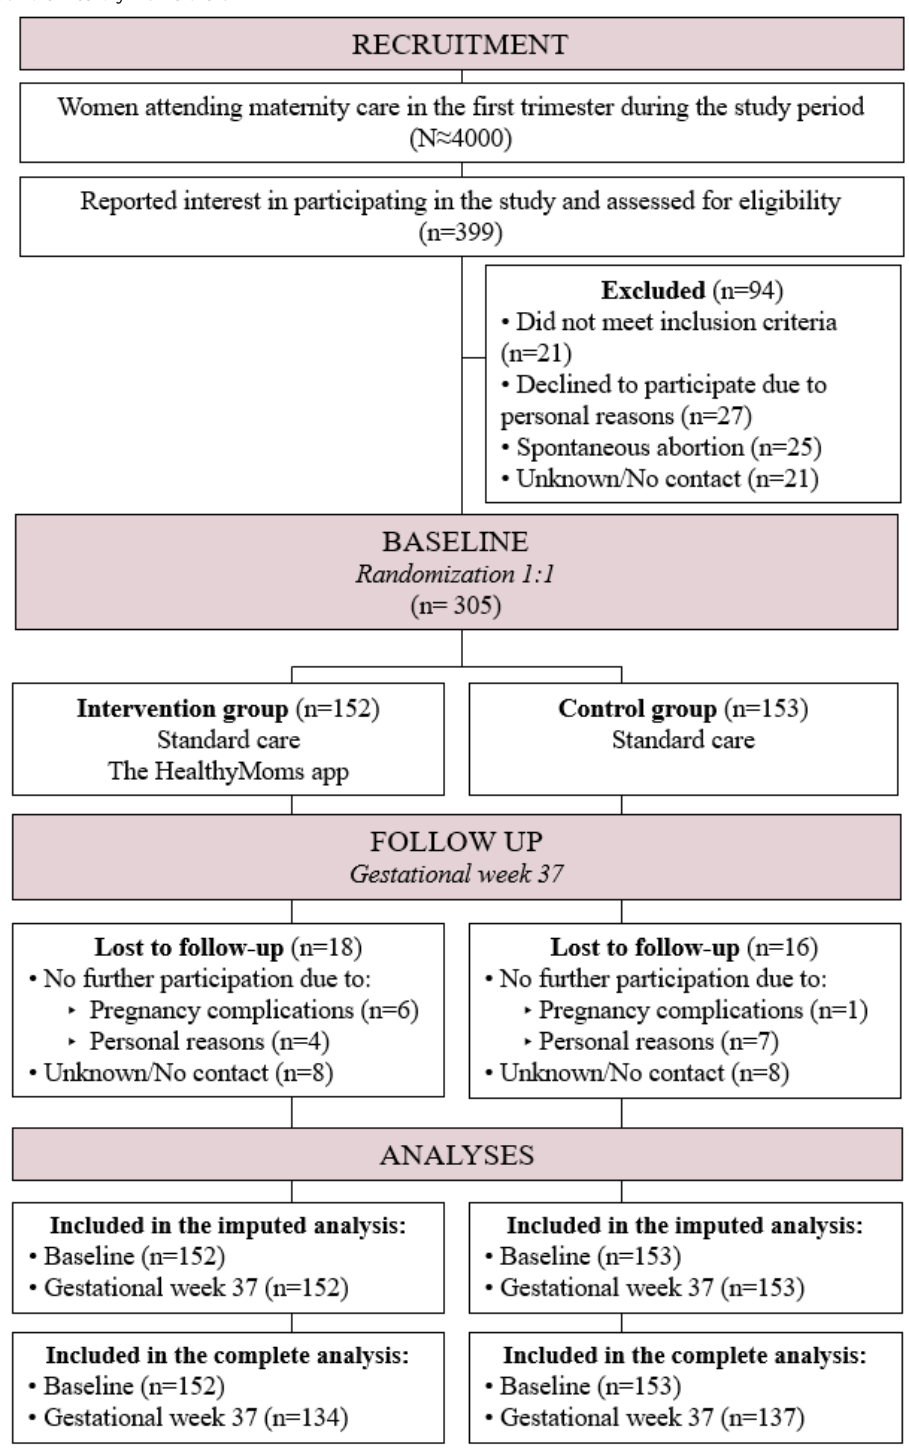
Figure 2. Flowchart of the HealthyMoms